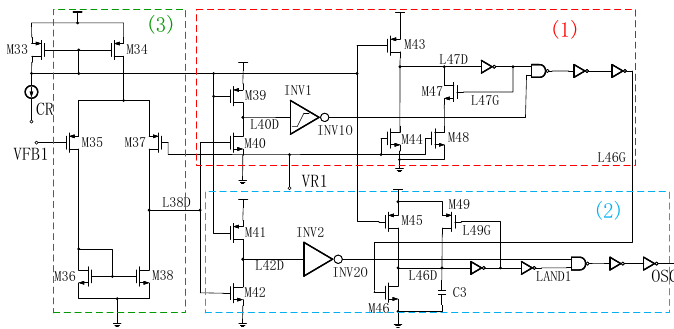
Figure 4. VO-DET circuit structure diagram.